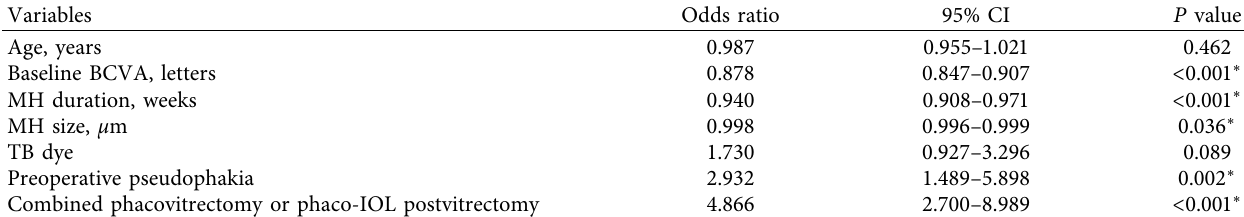
Table 4: Multiple logistic regression for VA increase ≥ 15 ETDRS letters between baseline and final follow-up † . Variables